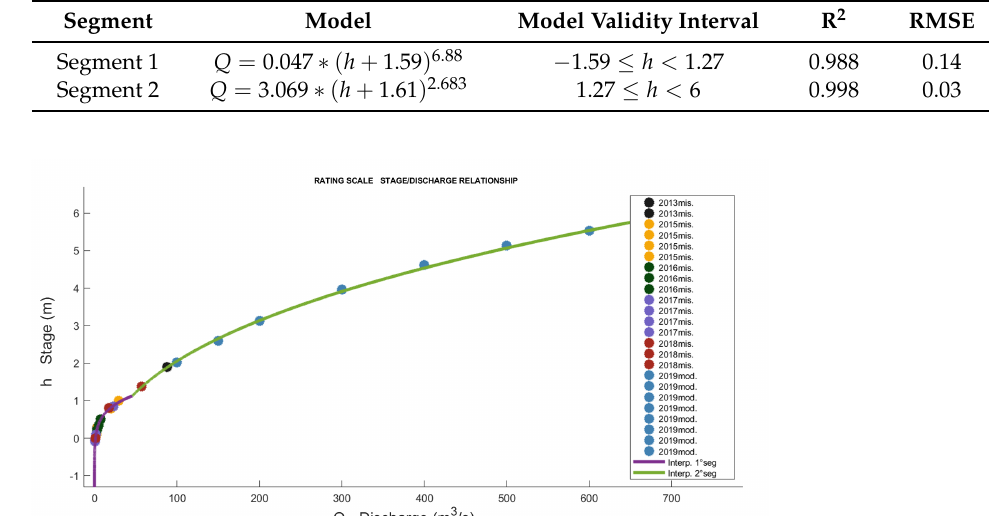
Table 7. Camponocecchio station models of the Esino River.